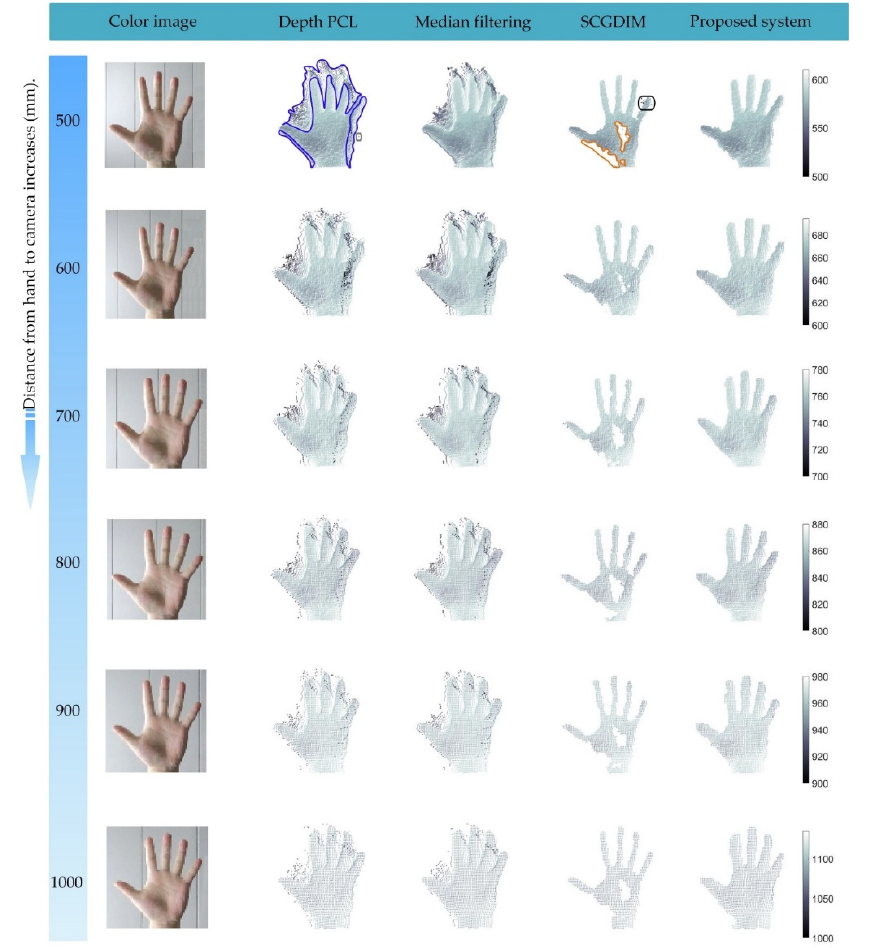
Figure 8. Comparisons at different distances by using Kinect v2.